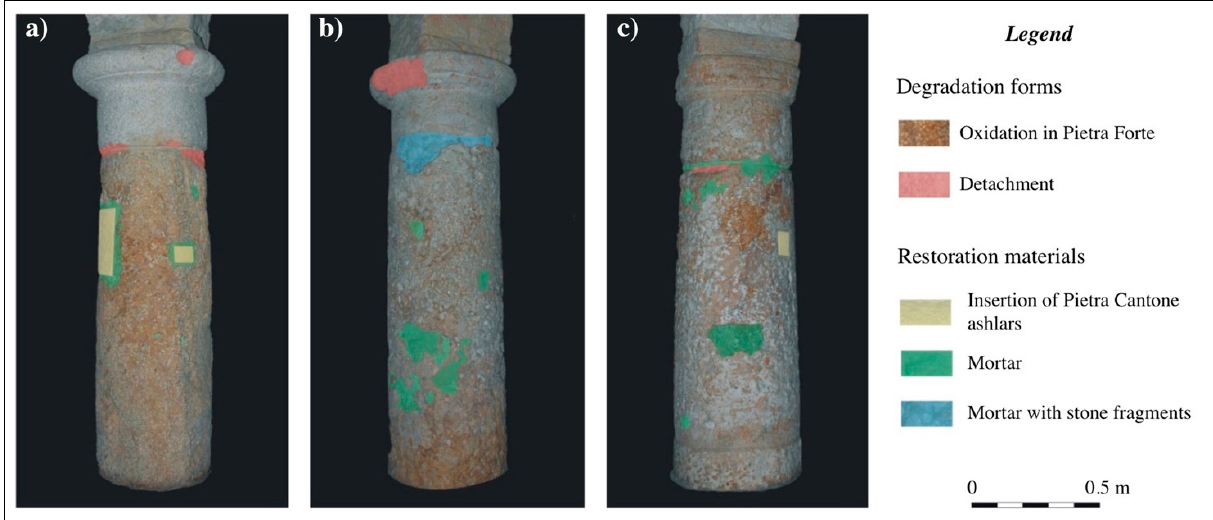
Figure 4. Macroscopic characteristics of the studied columns: ( a ) Column 1; ( b ) Column 2; ( c ) Column 3.